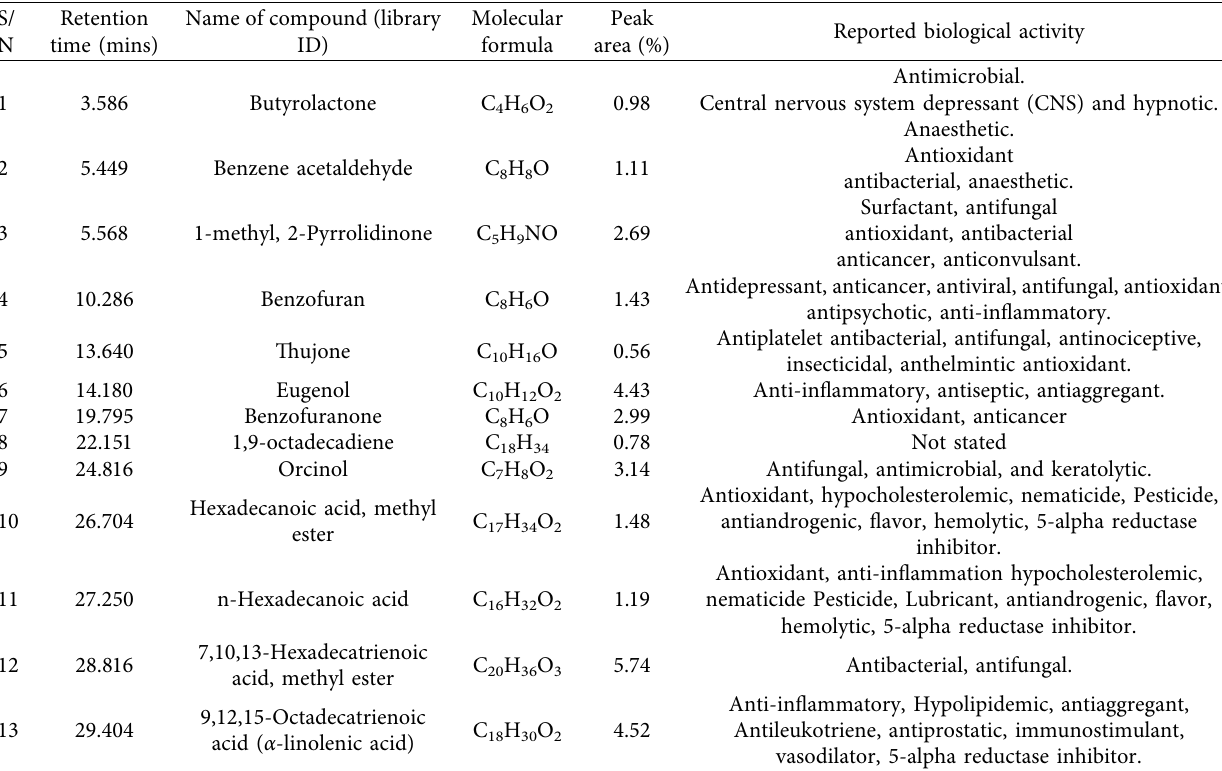
Table 3: Some GC—MS identified bioactive compounds of the hexane fraction of C. crepidioides leaf extract that may be responsible for observed